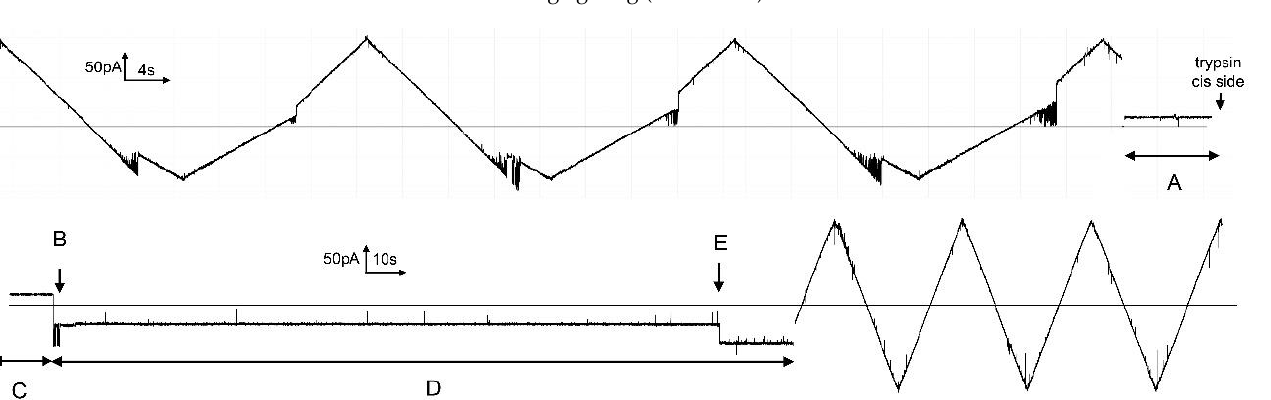
Figure 11. Trypsin cleavage of the sensor of subunit 1 from the cis side but not from the trans side. On the left side of the uppermost tracing, a single Triplin is responding to the applied triangular